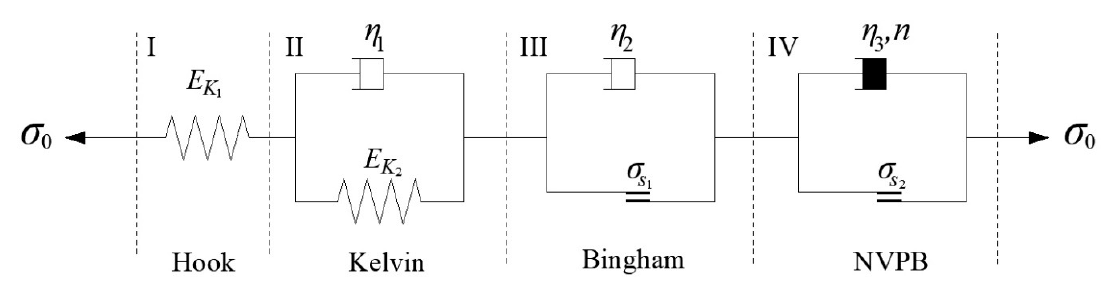
Figure 8. Nonlinear creep model of AS: ( I ) Hook elastic element, ( II ) Kelvin viscoelastic model, ( III ) Bingham model, ( IV ) the nonlinear volume plasticity Bingham (NVPB) model.